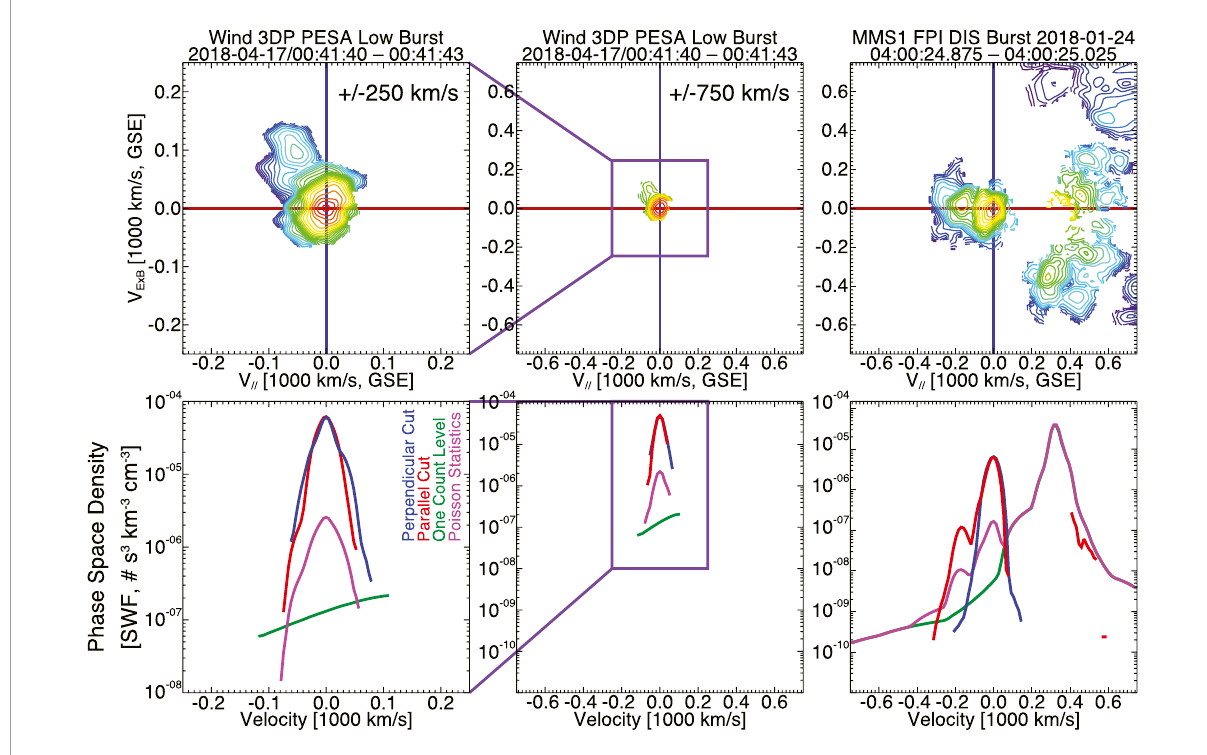
FIGURE 2 Illustrative example ion VDFs from Wind 3DP (Wilson et al., 2021) and MMS DIS (Pollock et al., 2016). The format is similar to that of Figure 1 except there is an extra panel for PESA Low showing the zoomed-in view of the VDF (i.e., first column). All columns show VDFs that have been transformed to the incident core, bulk flow rest frame (i.e., defined by centering the peak phase space density on the origin of this field-aligned coordinate